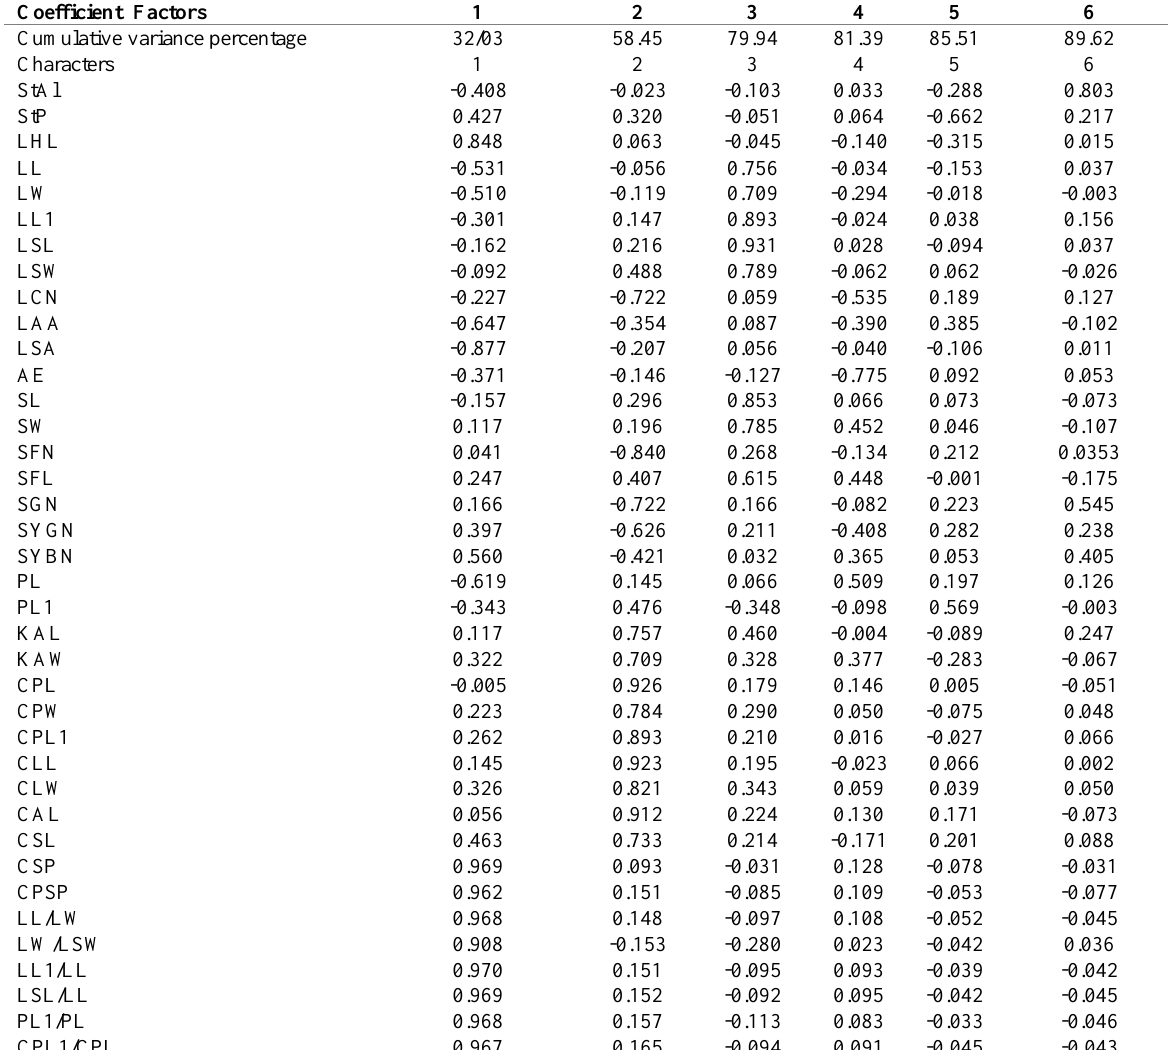
Table 5. The results of principal component